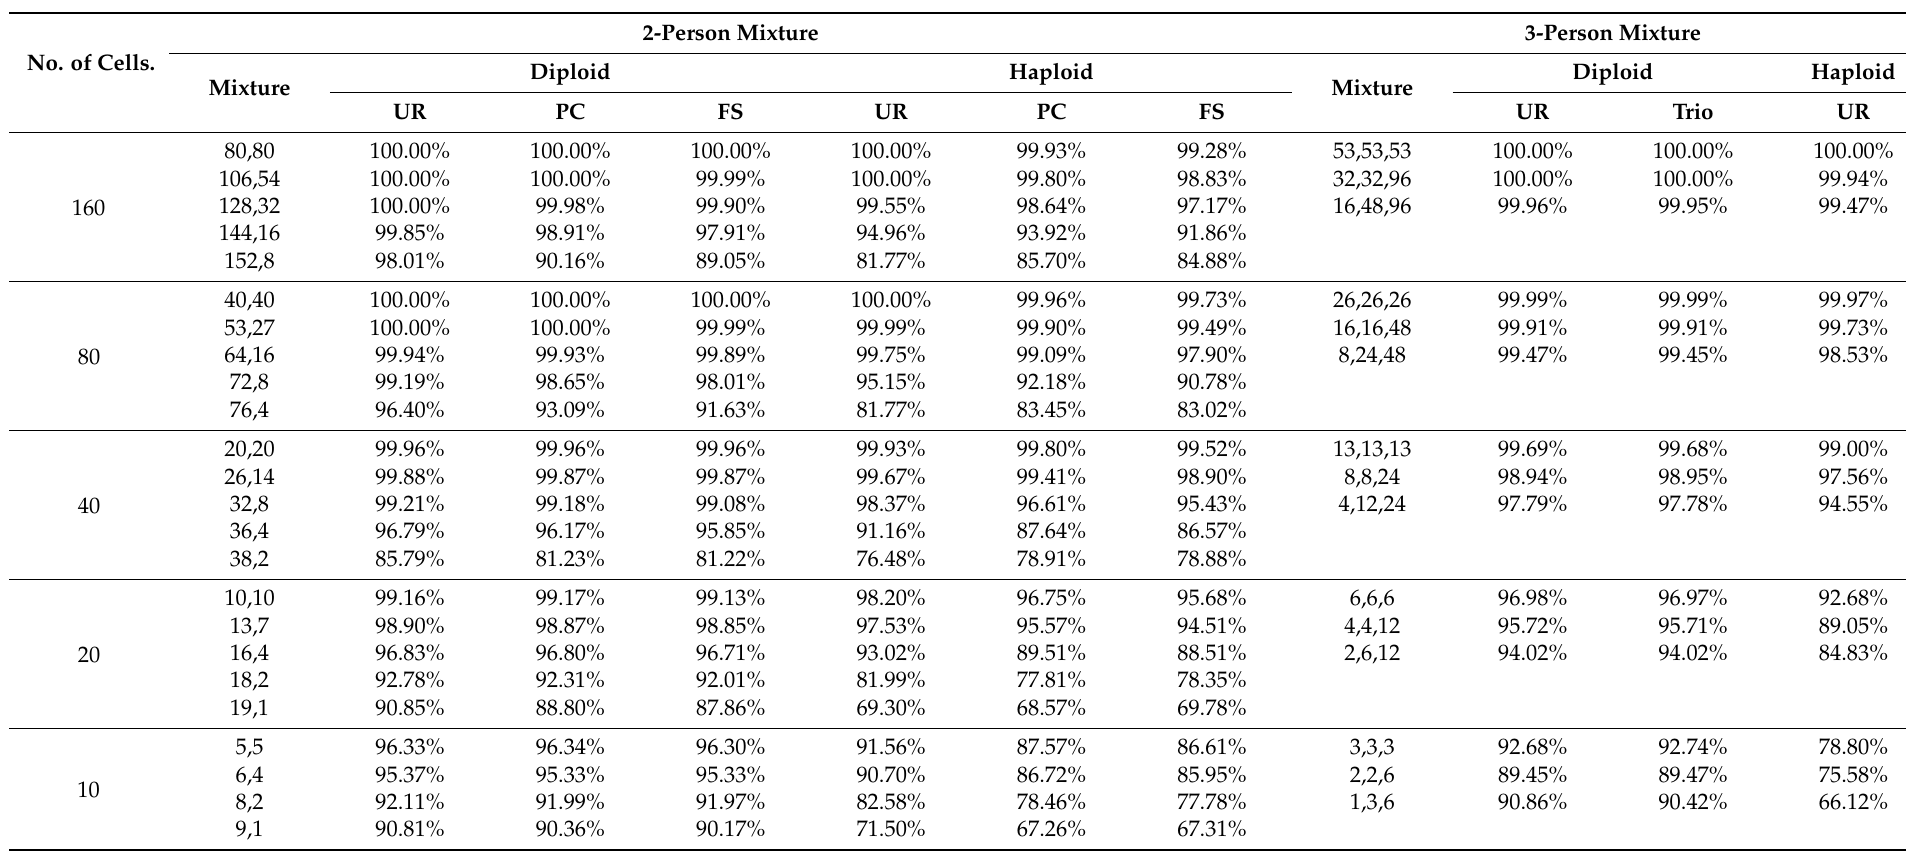
Table 3. The average of the average accuracies of consensus alleles compared with the true alleles of the contributors. Only the mixtures with the correct NOC estimation were included. The NOC was determined using the EM algorithm and Silhouettes method. D = 0.2; e = 0.01; 10,000 simulations for each mixture scenario.